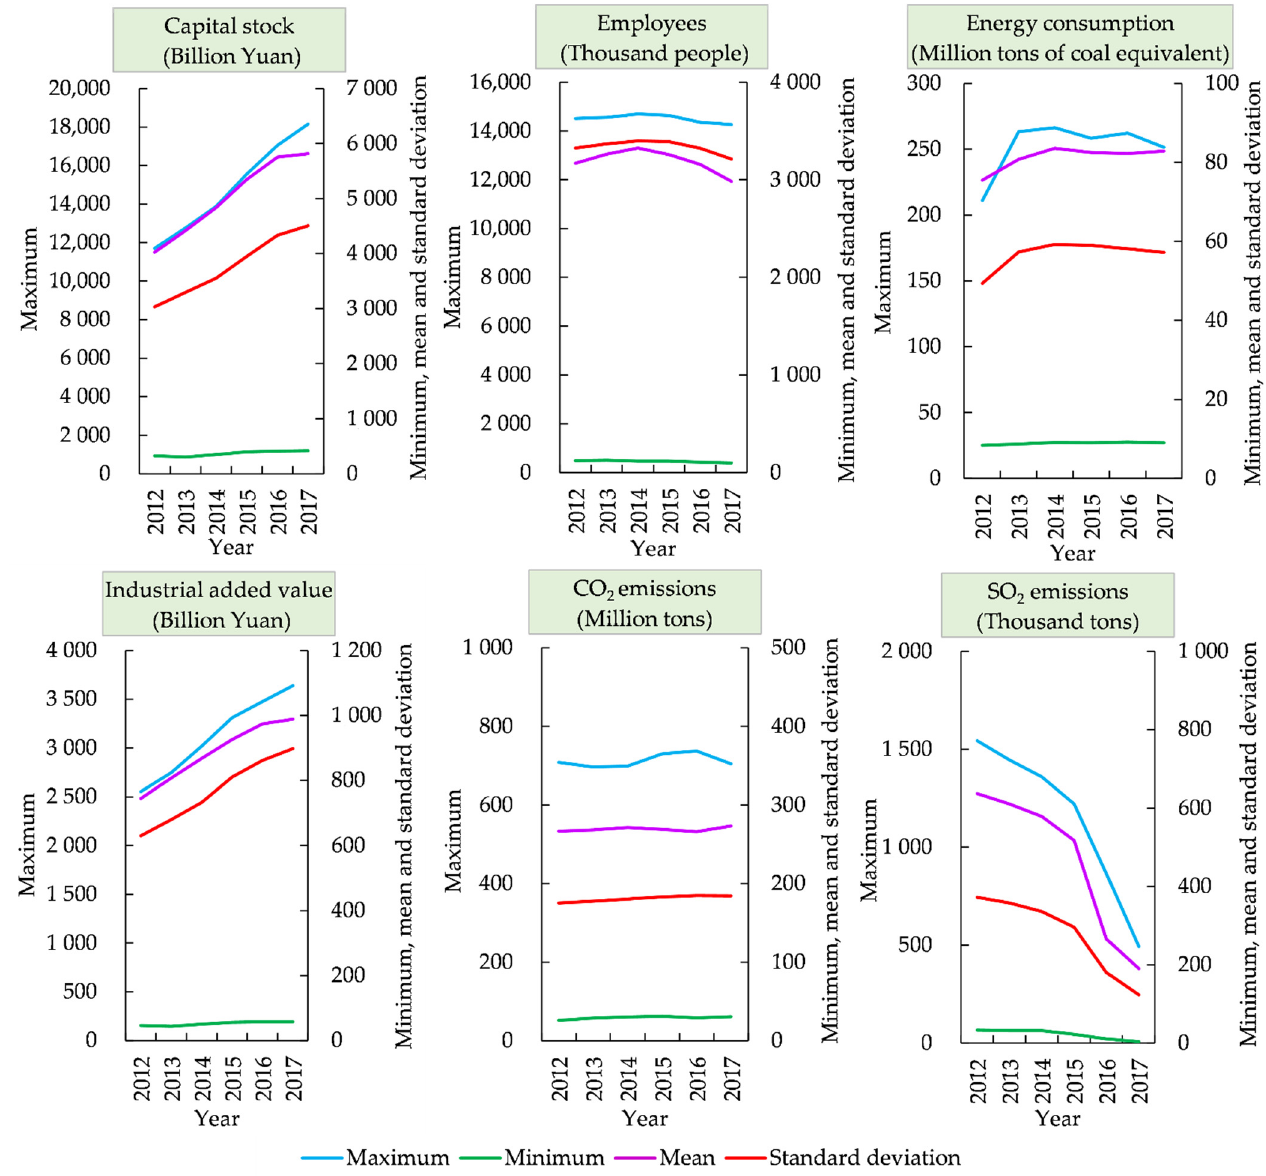
Figure 3. Statistical description of input and output